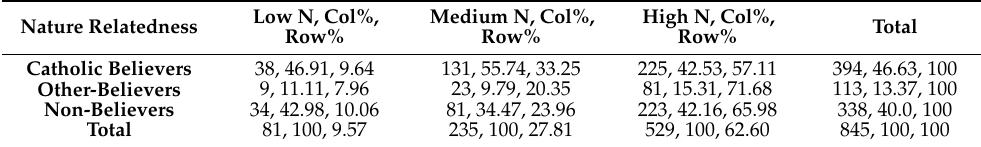
Table A5. Cross-table religious groups and nature relatedness.